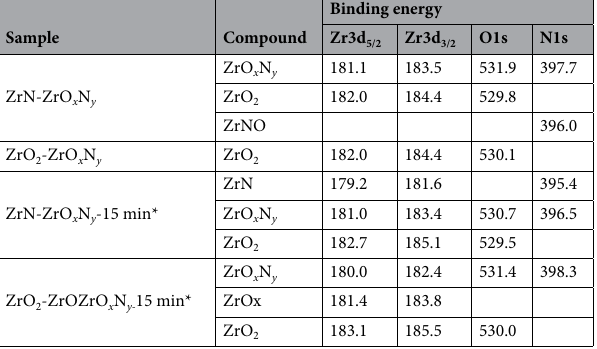
Table 1. Summary of XPS binding energy values. *After 15 min sputter etching.